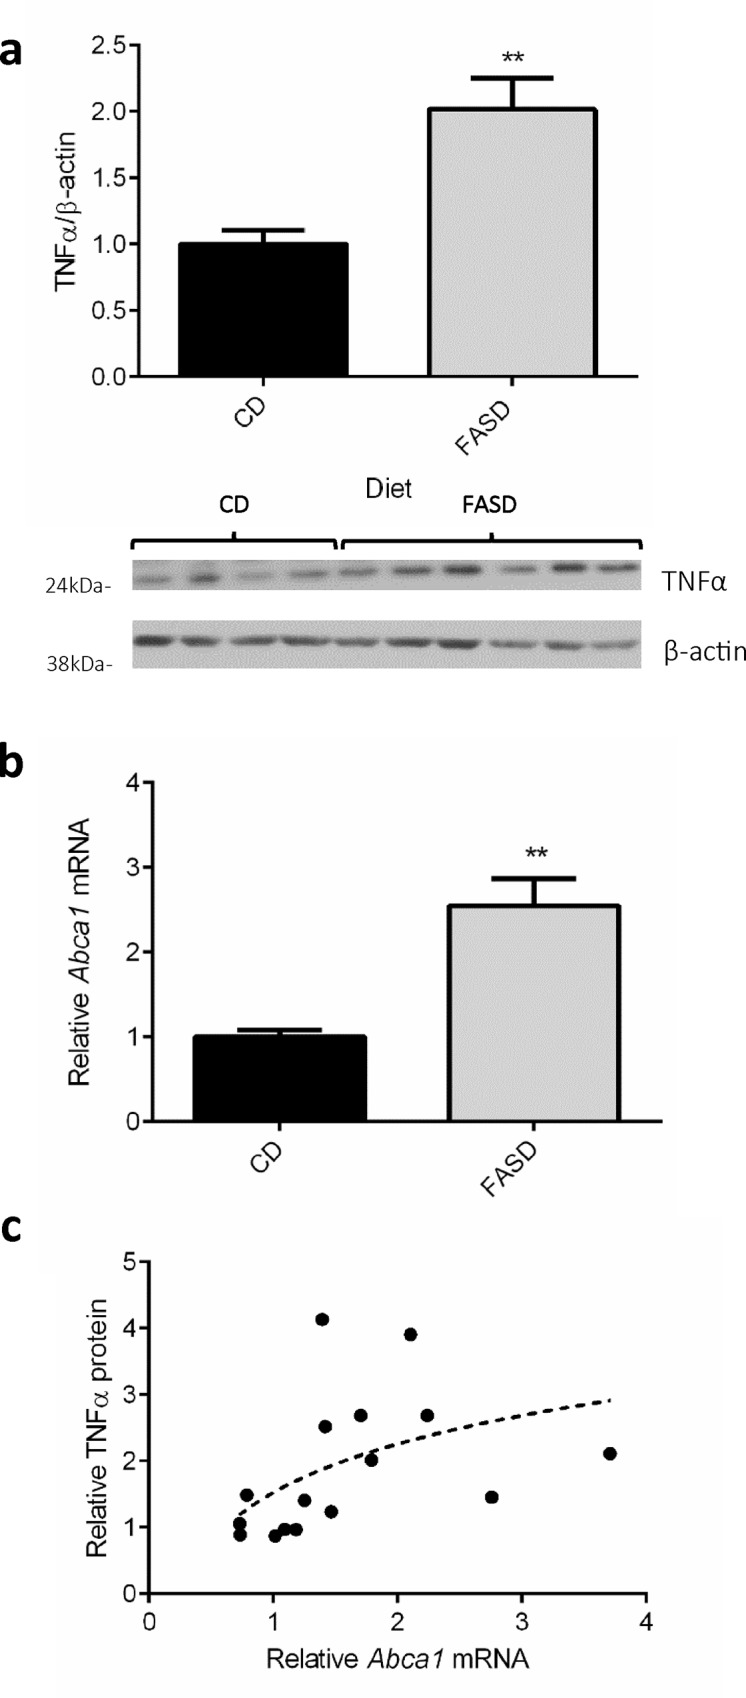
Differences in TNFα immunoreactive protein in brain and in relative Abca1 mRNA in liver between CD and FASD Mthfr
+/+ mice at 7 dpi.Values are means ± SEM for A and B. (a) FASD mice (grey bar; 3 experiments combined; n = 10) had significantly higher levels of TNFα protein in brain compared with CD mice (black bar; 3 experiments combined; n = 7). Representative Western blot is shown below the graph. (b) Livers of FASD mice (grey bar; 3 experiments combined; n = 9) had significantly higher relative Abca1 mRNA levels than livers of CD mice (black bar; 3 experiments combined; n = 9)). (c) Brain TNFα protein correlated with Abca1 mRNA levels in liver of mice in both dietary groups (rs = 0.63, Spearman correlation, p = 0.01; n = 16). **p<0.01, unpaired t-test.